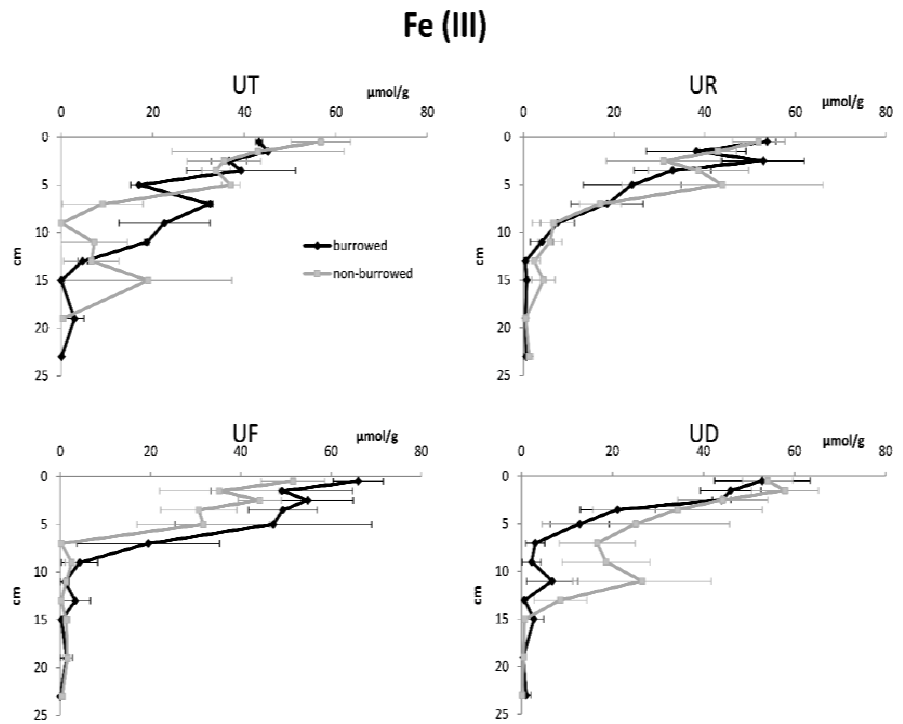
Table 1. Analysis of variance (ANOVA) for sediment properties among depth, habitat and burrow. Source of d.f. Sum of Squares (SS) Mean Square (MS) Variation Figure 5. Vertical variation of oxidized iron pools, Fe (III) in burrowed and non-burrowed sediments of U. triangularis (UT), U. rosea (UR), U. forcipata (UF) and U. paradussumieri (UD) habitat.